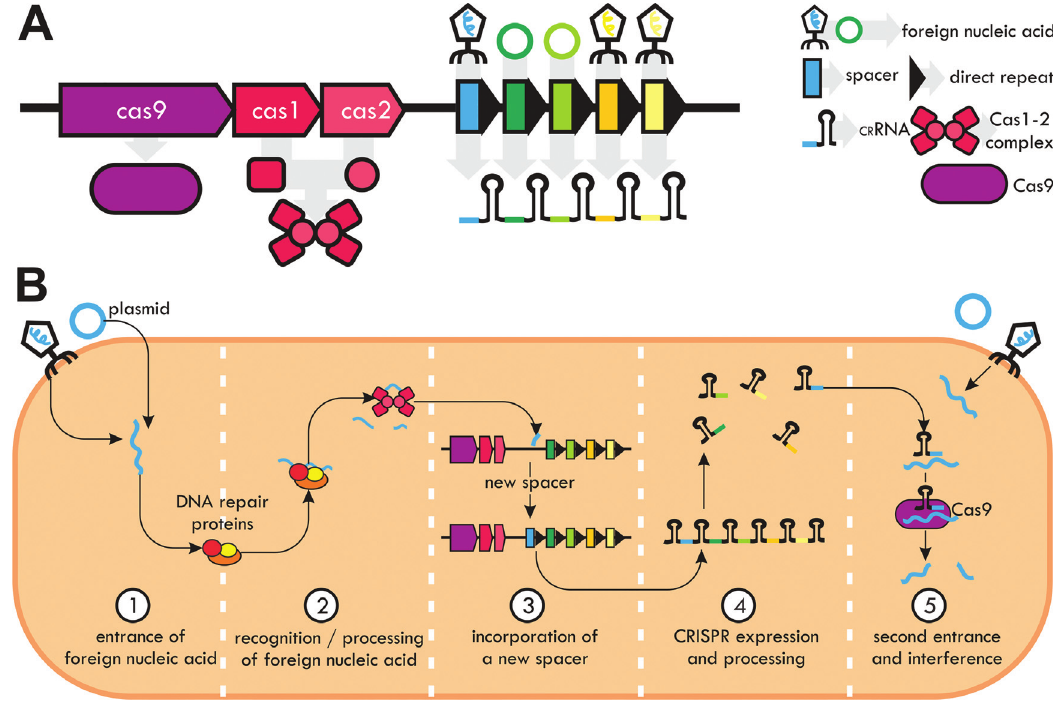
Figure 1 - Features of CRISPR systems. (A) Main structure of a CRISPR system. For simplicity, a type II system, containing only the Cas9 protein as the interference effector, is displayed. (B) Steps of a CRISPR system activity, from foreign nucleic acid recognition and spacer incorporation (a step called adaptation) to